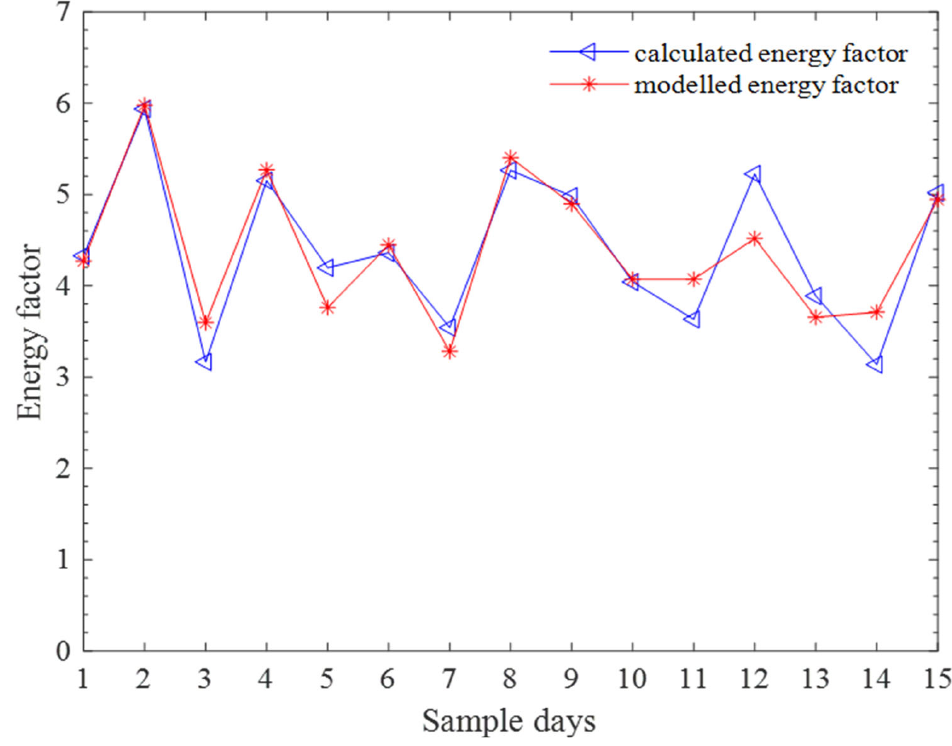
Figure 12. Calculated and modeled energy factor of the DX ‐ SAHP water heater.